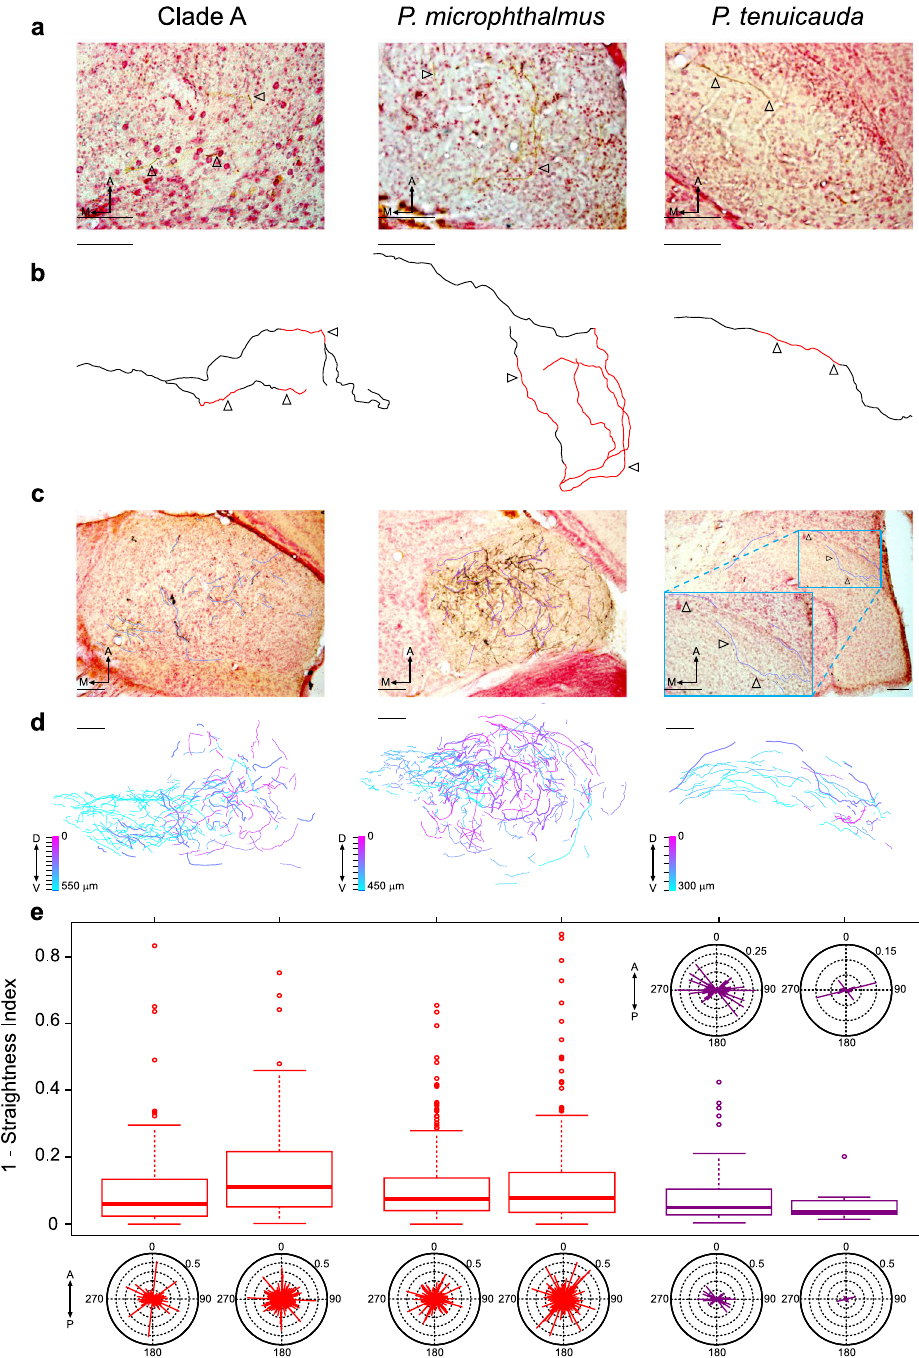
Figure 6. Axonal projections from hindbrain cells are long and follow a convoluted path after entering ELa, but not EL. ( a ) Representative photomicrographs of 50- µ m horizontal sections of the brain at the level of ELa of a clade-A species ( B . brachyistius , left) and of P . microphthalmus (center), and at the level of EL in P . tenuicada (right), depicting stained contralateral axonal projections (arrowheads). ( b ) Reconstruction of individual axons by tract tracing from 50- µ m horizontal sections of the brain at the level of ELa of a clade-A species (left, B . brachyistius , 7 sections) and of P . microphthalmus (center, 4 sections), and at the level of EL of P . tenuicauda (right, 5 sections). Arrowheads in ( b ) indicate the stained axonal segments depicted in ( a ) and the red segments of the reconstructed axons in ( b ) were obtained from the corresponding section in ( a ), whereas the black segments were stained axonal segments from adjacent sections. ( c ) Representative photomicrographs and tracings of the axonal segments from one 50- µ m horizontal section of the right ELa of a clade-A species ( B . niger , left) and P . microphthalmus (center), and of the right EL of P . tenuicauda (right) used for calculating the angle of axonal projections and how much the axonal segments deviate from a straight line (calculated as 1- straightness index; see main text and Methods). Tracings in ( c ) are shifted to facilitate view of the traces and the associated labeled axonal segments. ( d ) Plots of axonal segments combined from all the photomicrographs